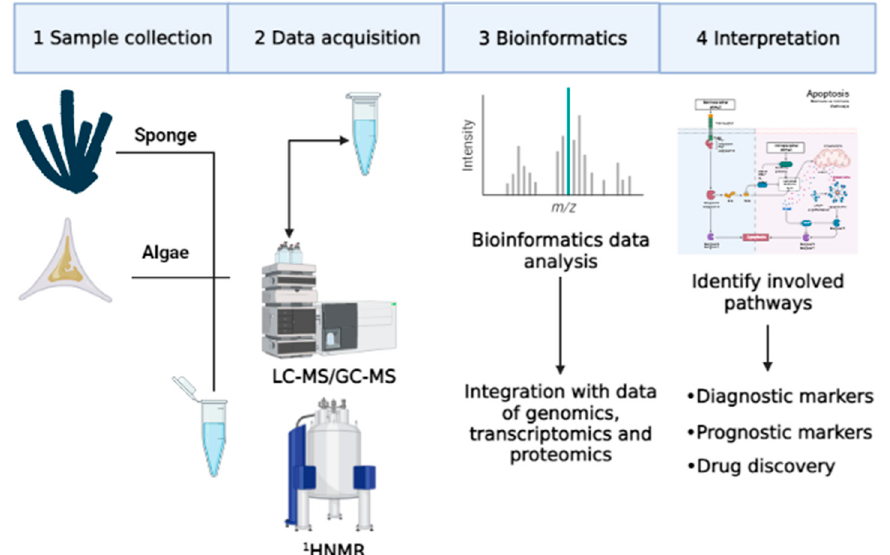
Figure 3. Main steps of metabolomics